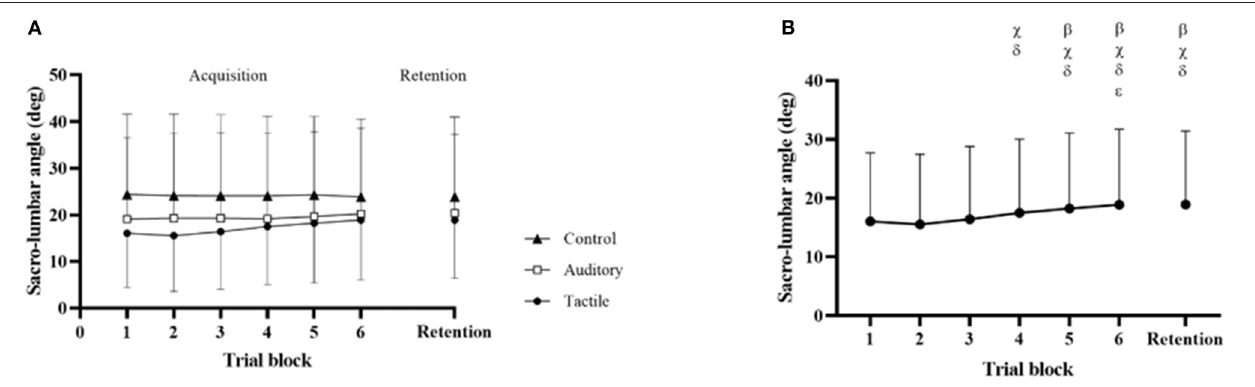
FIGURE 5 | Condition × Trial effect across the 3 conditions (A) , and trial effect in the tactile condition (B) . β , χ , δ , and ε indicate significant difference with block 1, block 2, block 3, and block 4 respectively.